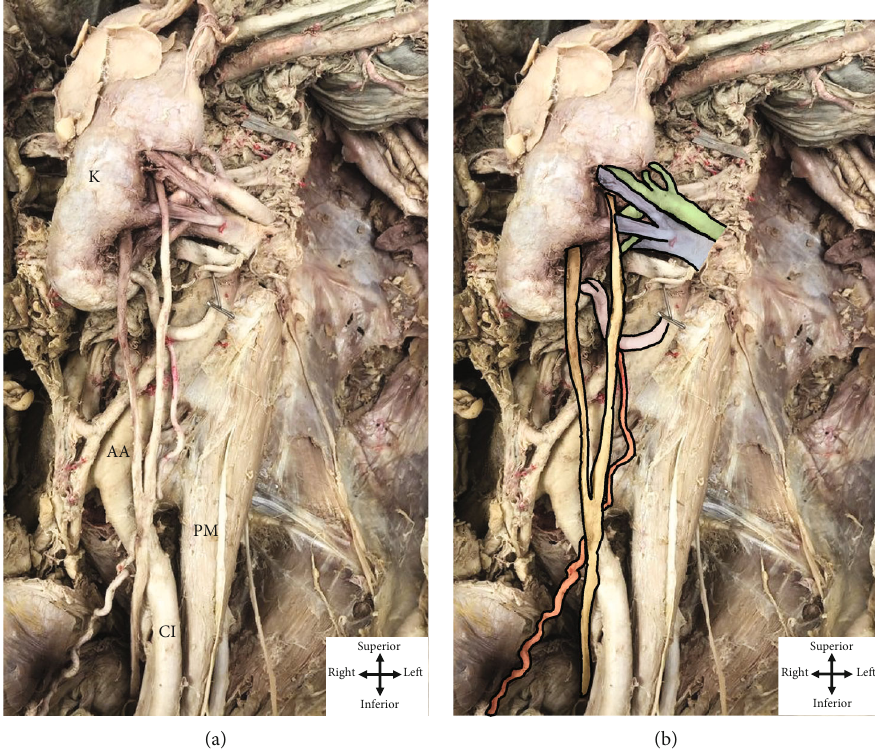
Figure 2: The anatomical presentation of the posterior aspect of the left kidney. (a) depicts the relevant dissected structures associated with labeled landmarks while (b) depicts relevant structures pseudocolored for ease in visualization. The left kidney (K in (a)) has been re fl ected away from the left posterior abdominal wall to show the posterior aspect of its hilum. The two contributions to the ureter (yellow in (b)) can be observed emerging from the hilum; the superior contribution emerges posterior to the renal vein, and the inferior contribution descends from the renal hilum anterior to the renal vein. The left aberrant renal artery (pink in (b)) is observed branching before entering the substance of the kidney. The left ovarian artery (red in (b)) emerges from the anterior aspect of the aberrant left renal artery. Five segmental arteries and the renal vein are also observed entering the renal hilum (green and blue, respectively, in